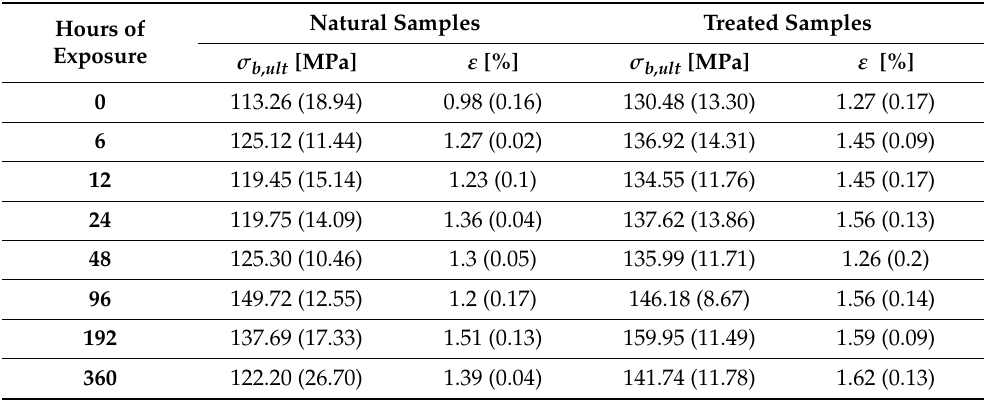
Table 1. Average values and standard deviation (in brackets) for bending strength and deformation of the external part of bamboo thickness, referring to treated and natural samples exposed to different UV radiation hours.